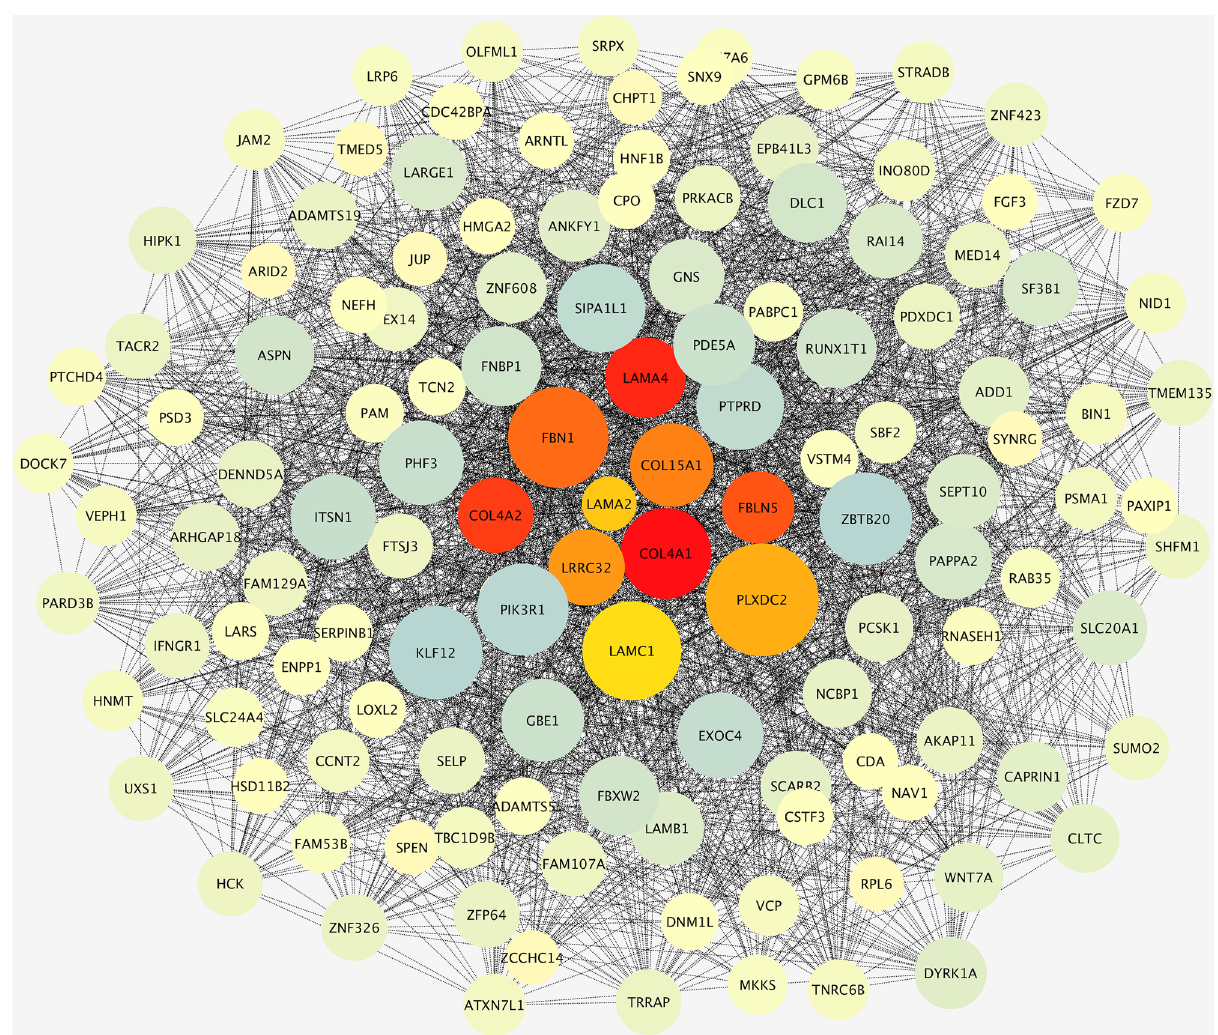
Figure 4. Subnetwork of hub genes extracted from CytoHubba. The figure shows the interconnections between hub genes and other genes in the